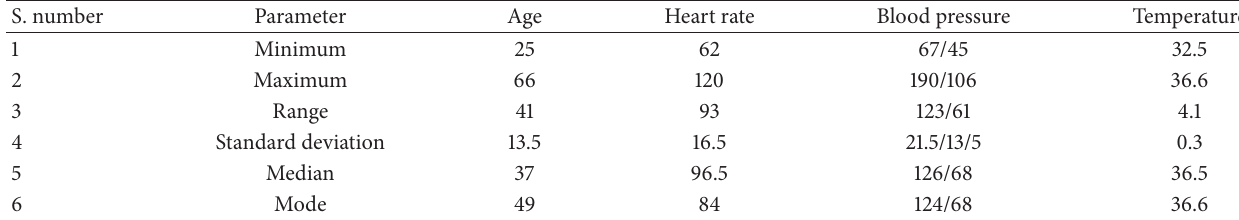
Table 4: Statistical data of patients.